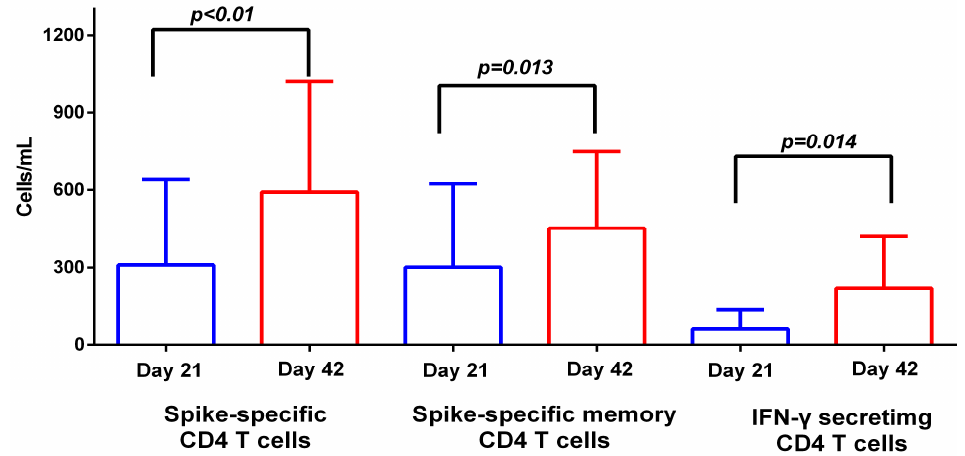
Figure 3. Cellular response to BNT162b2. Spike-specific CD4 T cells, spike-specific CD4 memory T cells and IFN- γ -secreting CD4 T cells before (D21) and 21 days (D42) after the second BNT162b2 dose in SARS-CoV-2 naïve individuals. Data are represented as mean values with standard deviation.